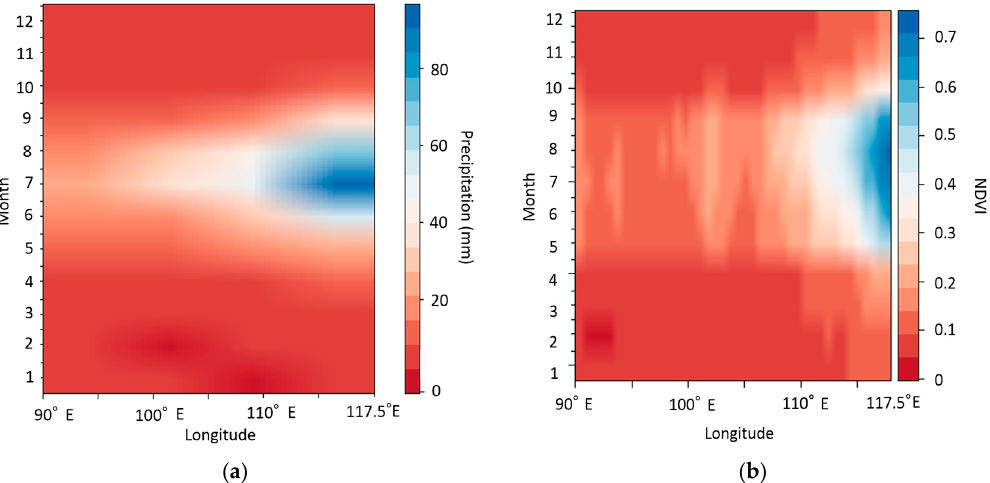
Figure 2. Hovmoller diagrams: ( a ) monthly precipitation and ( b ) monthly NDVI for the Gobi region averaged between 90° E–117.5° E and 40° N–47.5° N.